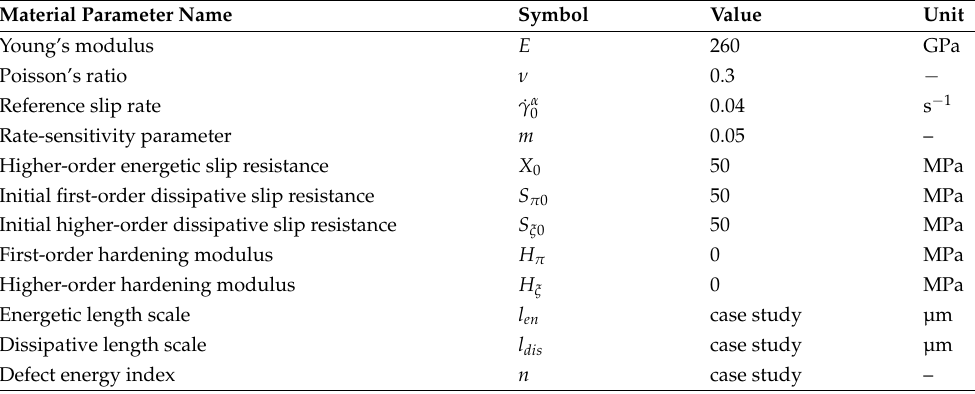
Table 1. The material parameters implied for simple shear of constrained layer undergoing small deformation, taken from [34] for comparison